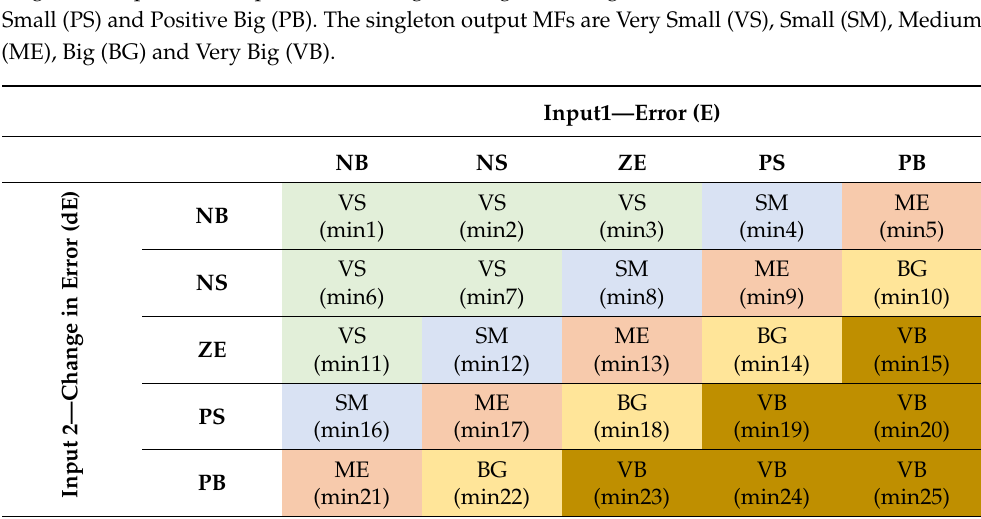
singleton outputs. The input MFs are Negative Big (NB), Negative Small (NS), Zero (ZE), Positive